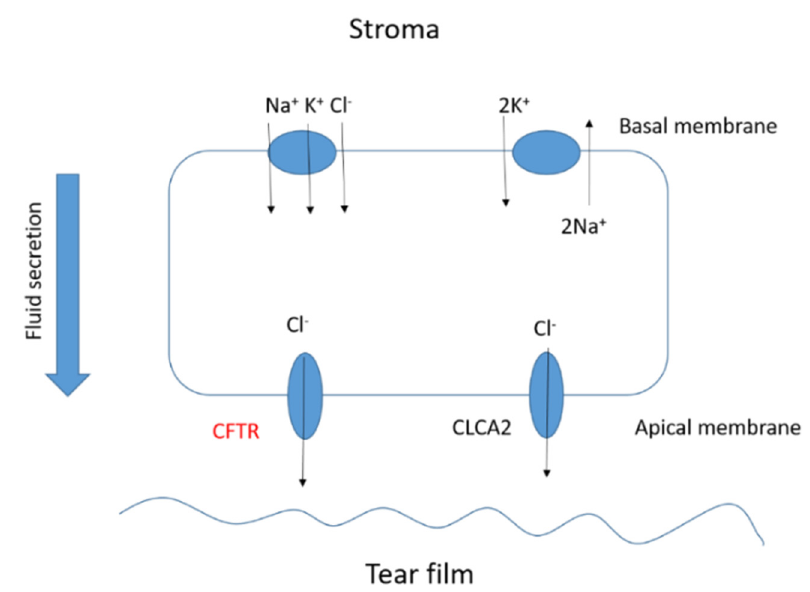
Figure 4. Basic scheme of the fluid transport in a corneal epithelial cell.